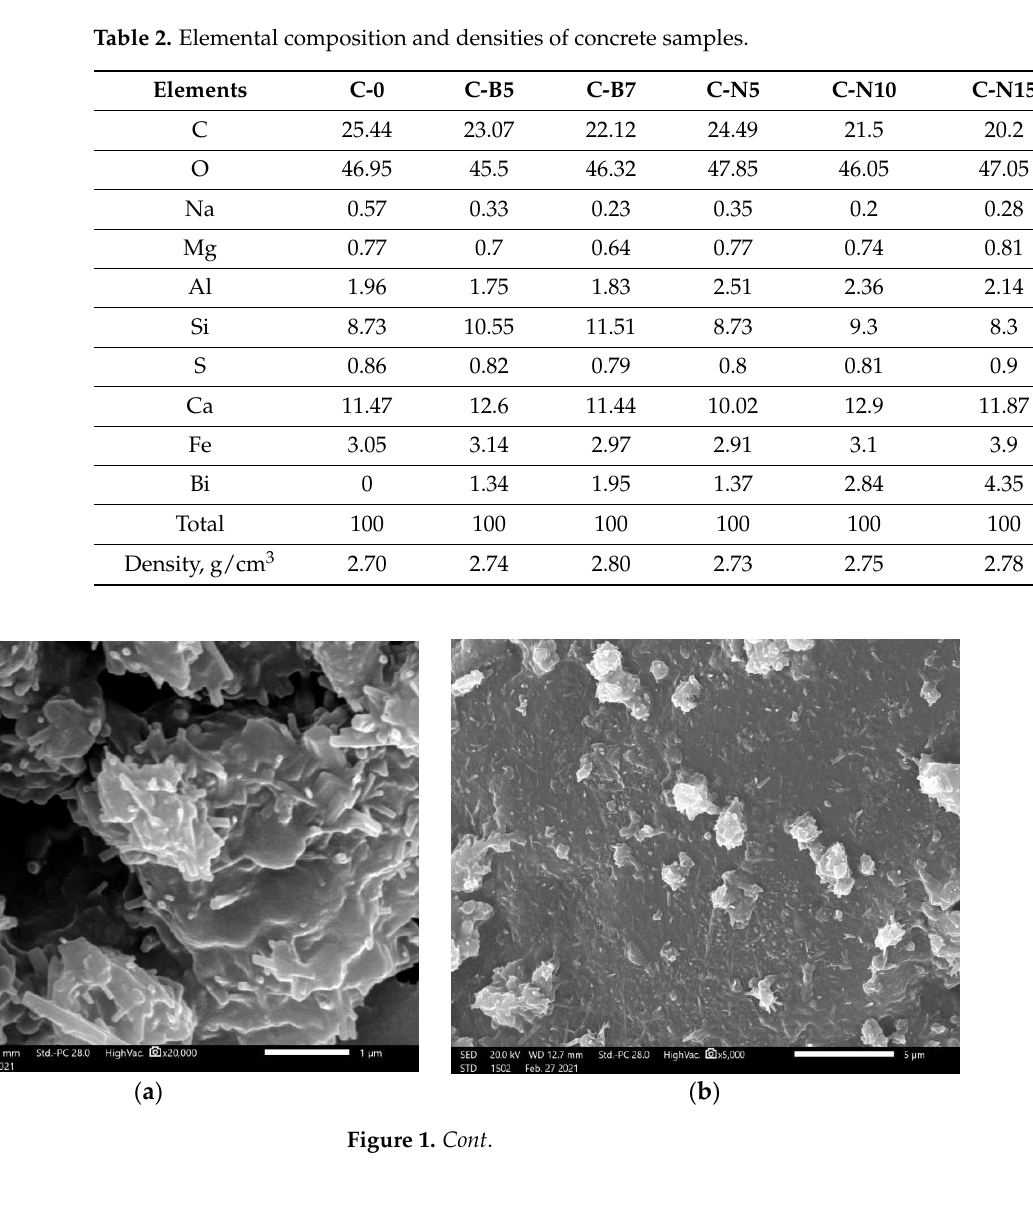
Table 1. The concrete sample mixes